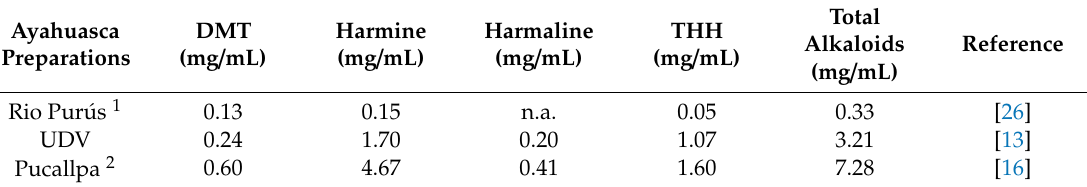
Table 1. Chemical composition and alkaloid content of ayahuasca